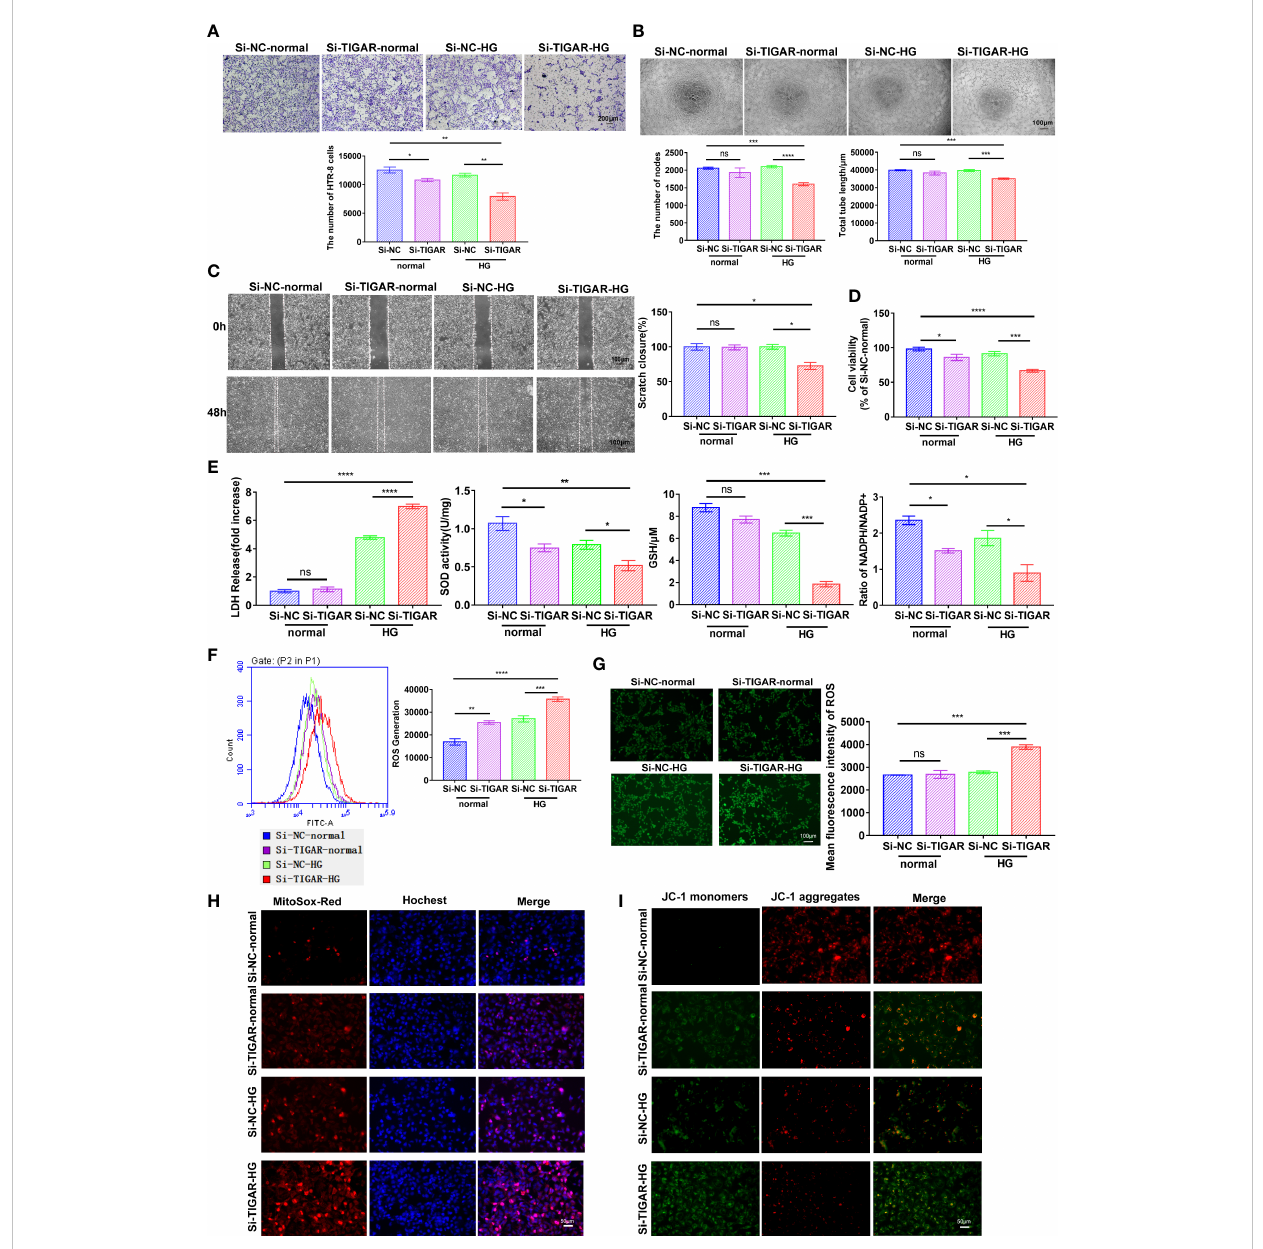
FIGURE 2 The effect of TIGAR loss on the viability and biological function of HTR-8/HTR-8/Svneo. (A) Representative images for invasion test and quanti fi cation of the number of cells per fi eld (x100). Scale bar: 200 m m. (B) Representative images for tube formation test and quanti fi cation of the number of nodes and tube length. Scale bar: 100 m m. (C) Representative images for scratch test and quanti fi cation of wound healing area. Scale bar: 100 m m. (D) Cell viability of HTR-8 treated with normal or HG, which was transfected with TIGAR ‐ siRNA (Si-TIGAR) or Negative control ‐ siRNA (Si- NC). (E) LDH release, SOD activity, GSH level and ratio of NADPH/NADP + were measured at 48h after speci fi c stimulus. All experiments were from at least three independent experiments. Data were expressed as mean ± SEM. Intracellular ROS levels in Si-TIGAR and Si-NC HTR-8 when treated under normal or HG condition were determined using DCFH-DA, as detected by fl ow cytometry (F) and photograph (G) The histogram shows the mean ROS production. Scale bar: 100 m m. Mitochondrial superoxide was evaluated by JC-1 staining (H) and MitoSOX Red staining (I) of HTR-8 cells. Scale bar: 50 m m. Data of the triple experiments are presented as the means ± SEM. *p < 0.05, **p < 0.01, ***p < 0.001, ****p < 0.0001 versus the indicated group, ns, no signi fi cance. GSH, glutathione; GSSG, oxidized glutathione; NADP+, nicotinamide adenine dinucleotide phosphate; NADPH, reduced NADP+; ROS, reactive oxygen